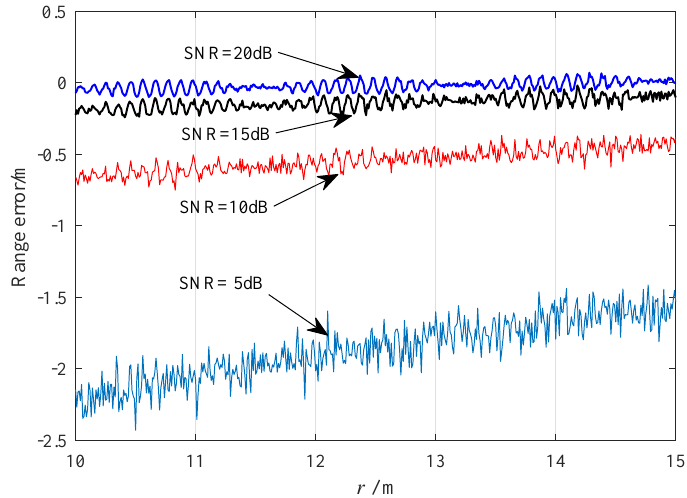
Figure 6. Range error versus r when signal-to-noise ratios (SNR) = 5 dB, 10 dB, 15 dB, 20